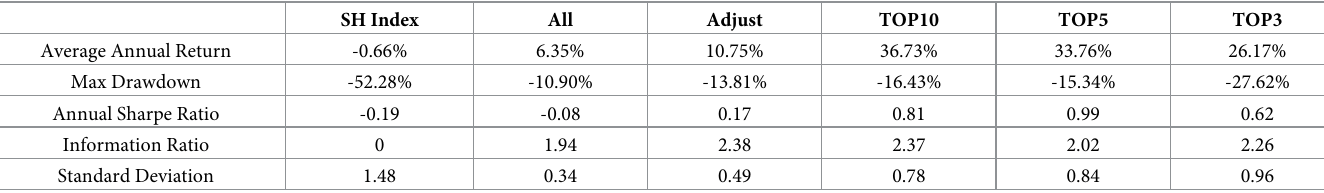
Table 4. Finance performance of two-day patterns predicting one day